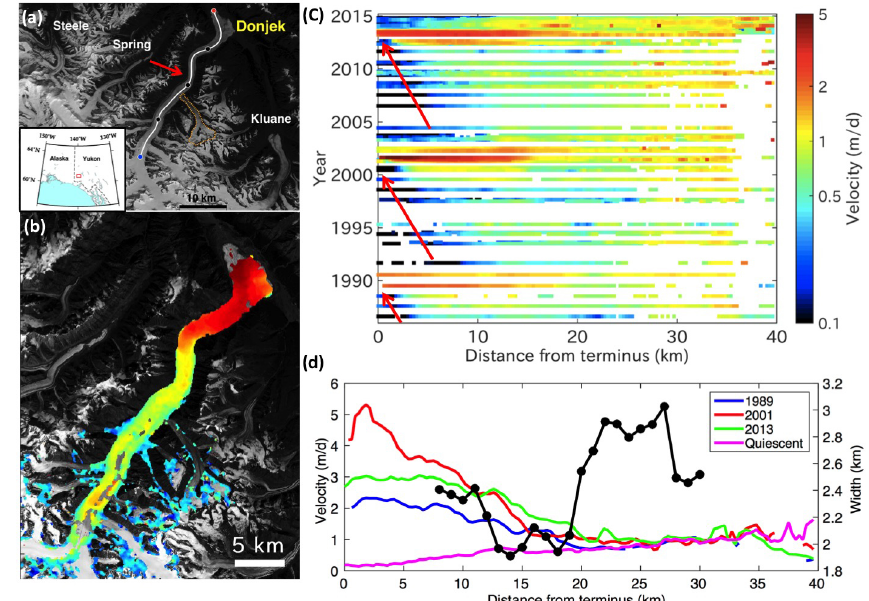
Figure 1. Glacier flow speeds and glacier extent. (a) Location of Donjek Glacier. The background is a Landsat 8 image acquired on 22 July 2014. The white line is the flow line used in (c) and (d) . The red and blue dots show the start and end points, whereas the black dots mark 10km intervals. The red arrow indicates a significantly narrower area of the valley and the dotted orange curves outline the last tributary. (b) A sample ice-speed map derived from two images acquired in August and September 2001. The colour scale (logarithmic) is the same as that in (c) . (c) Spatial-temporal velocity evolution along the flow line in (a) from 1986 to 2014. The red arrows indicate the propagation of the velocity front. (d) The black line shows the change in the valley width between 8 and 30km along the flow line. The blue, red, and green lines show the ice velocity associated with surging episodes in 1989, 2001, and 2003, respectively. The pink line is the averaged velocity between 2003 and 2011 (i.e. the quiescent